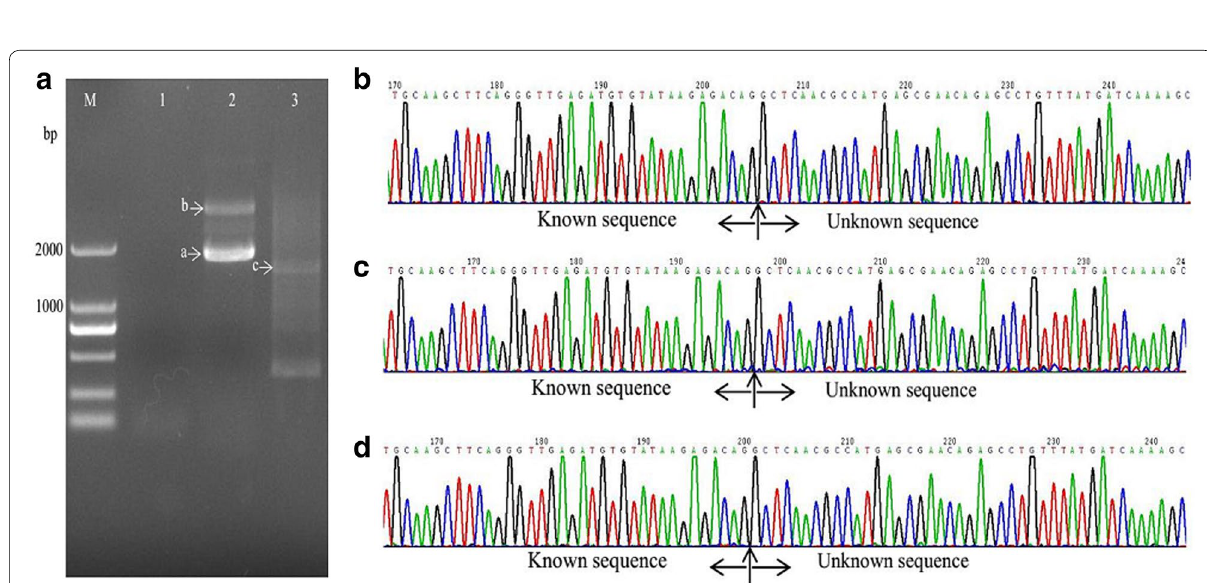
Fig. 3 Amplification and sequencing results of the sequence flanking the Tn5 insertion site of sample 2. a Amplification product shown on an agarose gel. Lanes 1–3 show the results of steps 1–3, respectively. b Chromatograms of DNA in band a. c Chromatograms of DNA in band b.